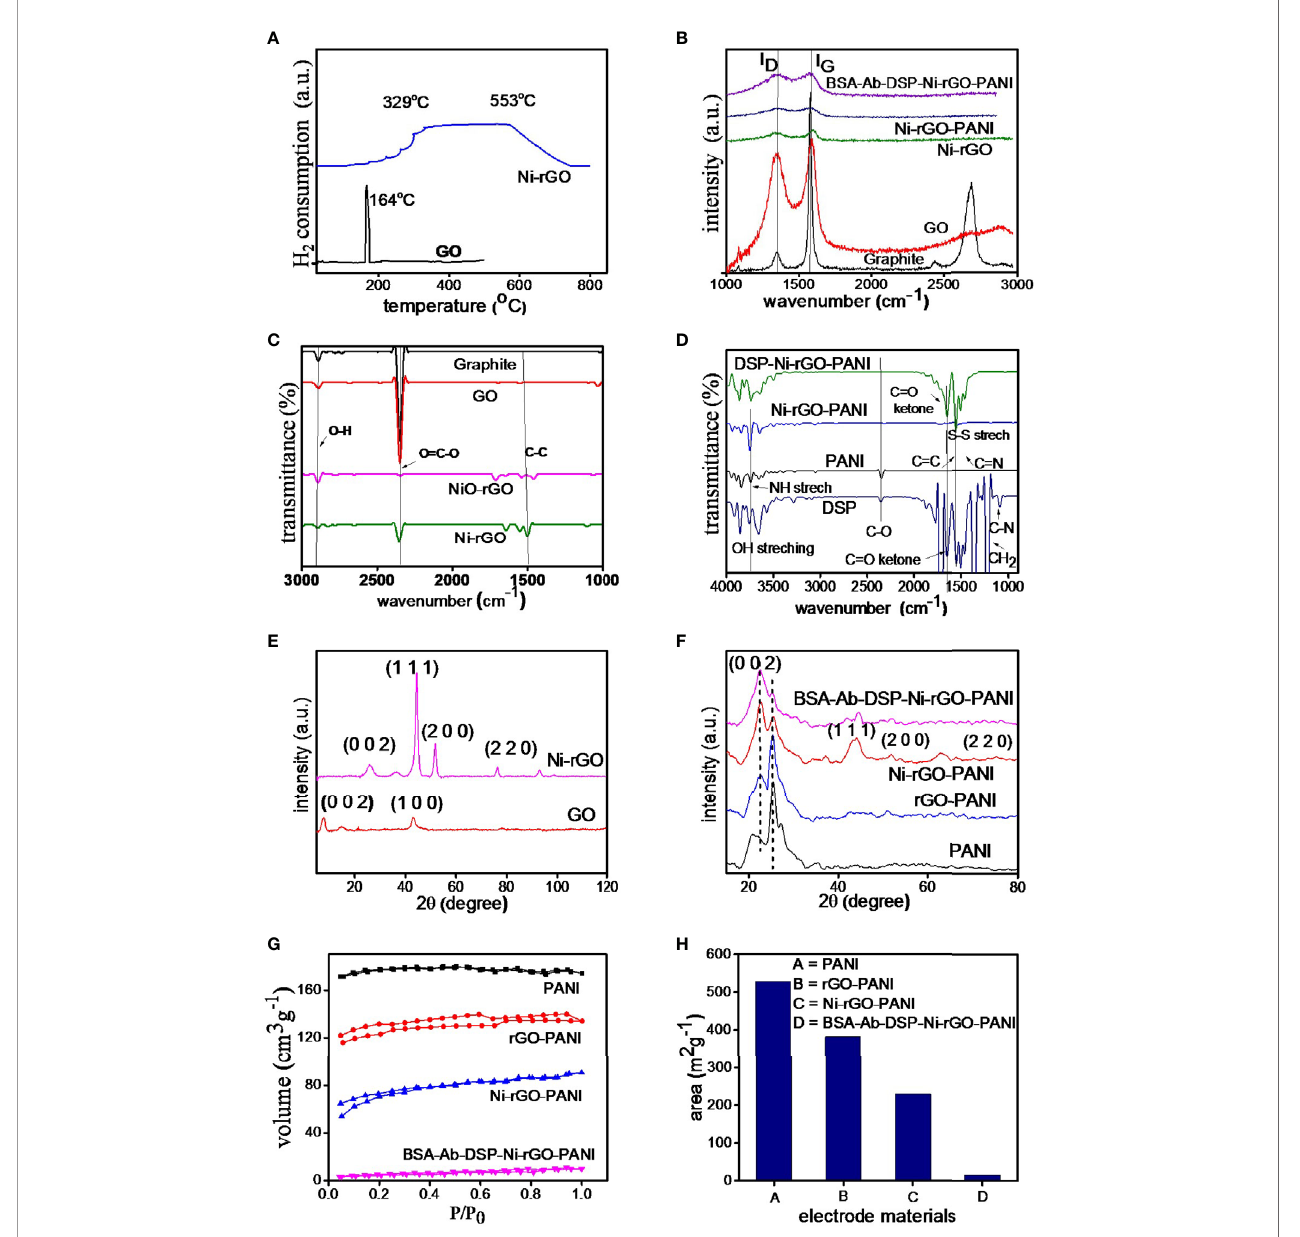
FIGURE 3 | (A) TPR of GO and NiO-GO, (B) RAMAN spectra of electrode materials, (C, D) FT-IR and (E, F) XRD spectra of the substrate and surface-modi fi ed materials, (G) BET isotherms and (H) surface area of the